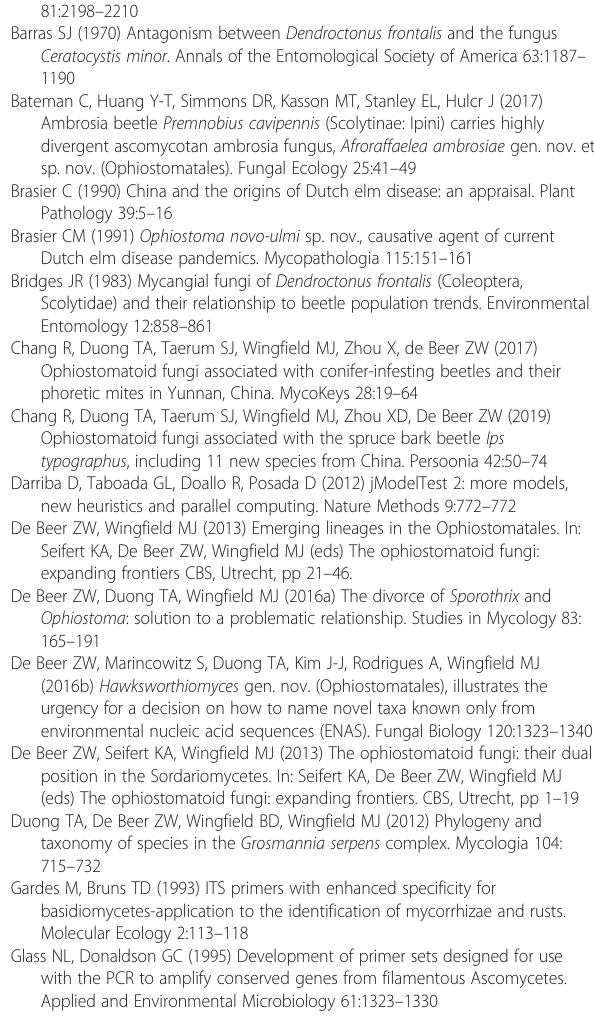
Additional file 1: Fig. S1. Phylogram obtained from ML analyses of the partial BT and EF gene of Ophiostoma clavatum complex. Sequences obtained in this study are printed in bold type. ML and MP bootstrap support values (1000 replicates, normal type) above 75% are indicated at the nodes. Posterior probabilities (above 0.9) obtained from BI are indicated by bold lines at the relevant branching points. T= ex-type Additional file 2: Fig. S2. Phylogram obtained from ML analyses of the partial BT and EF gene of Leptographium olivaceum complex. Sequences